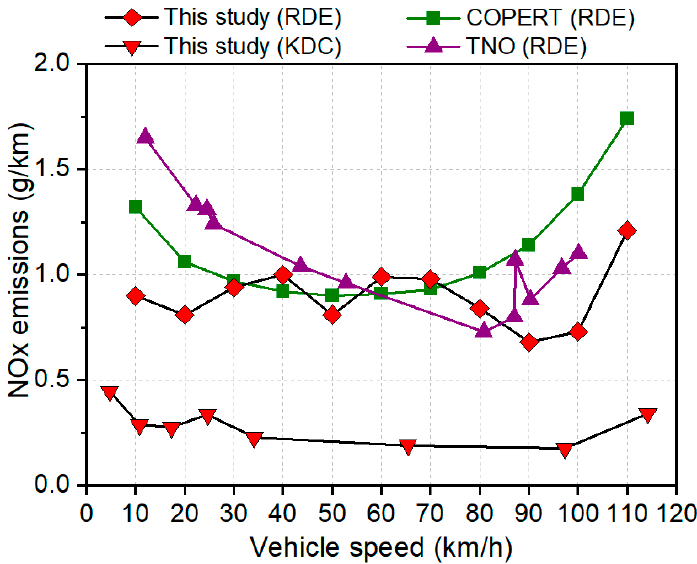
Figure 10. Comparison of NOx emission factors with previous studies.